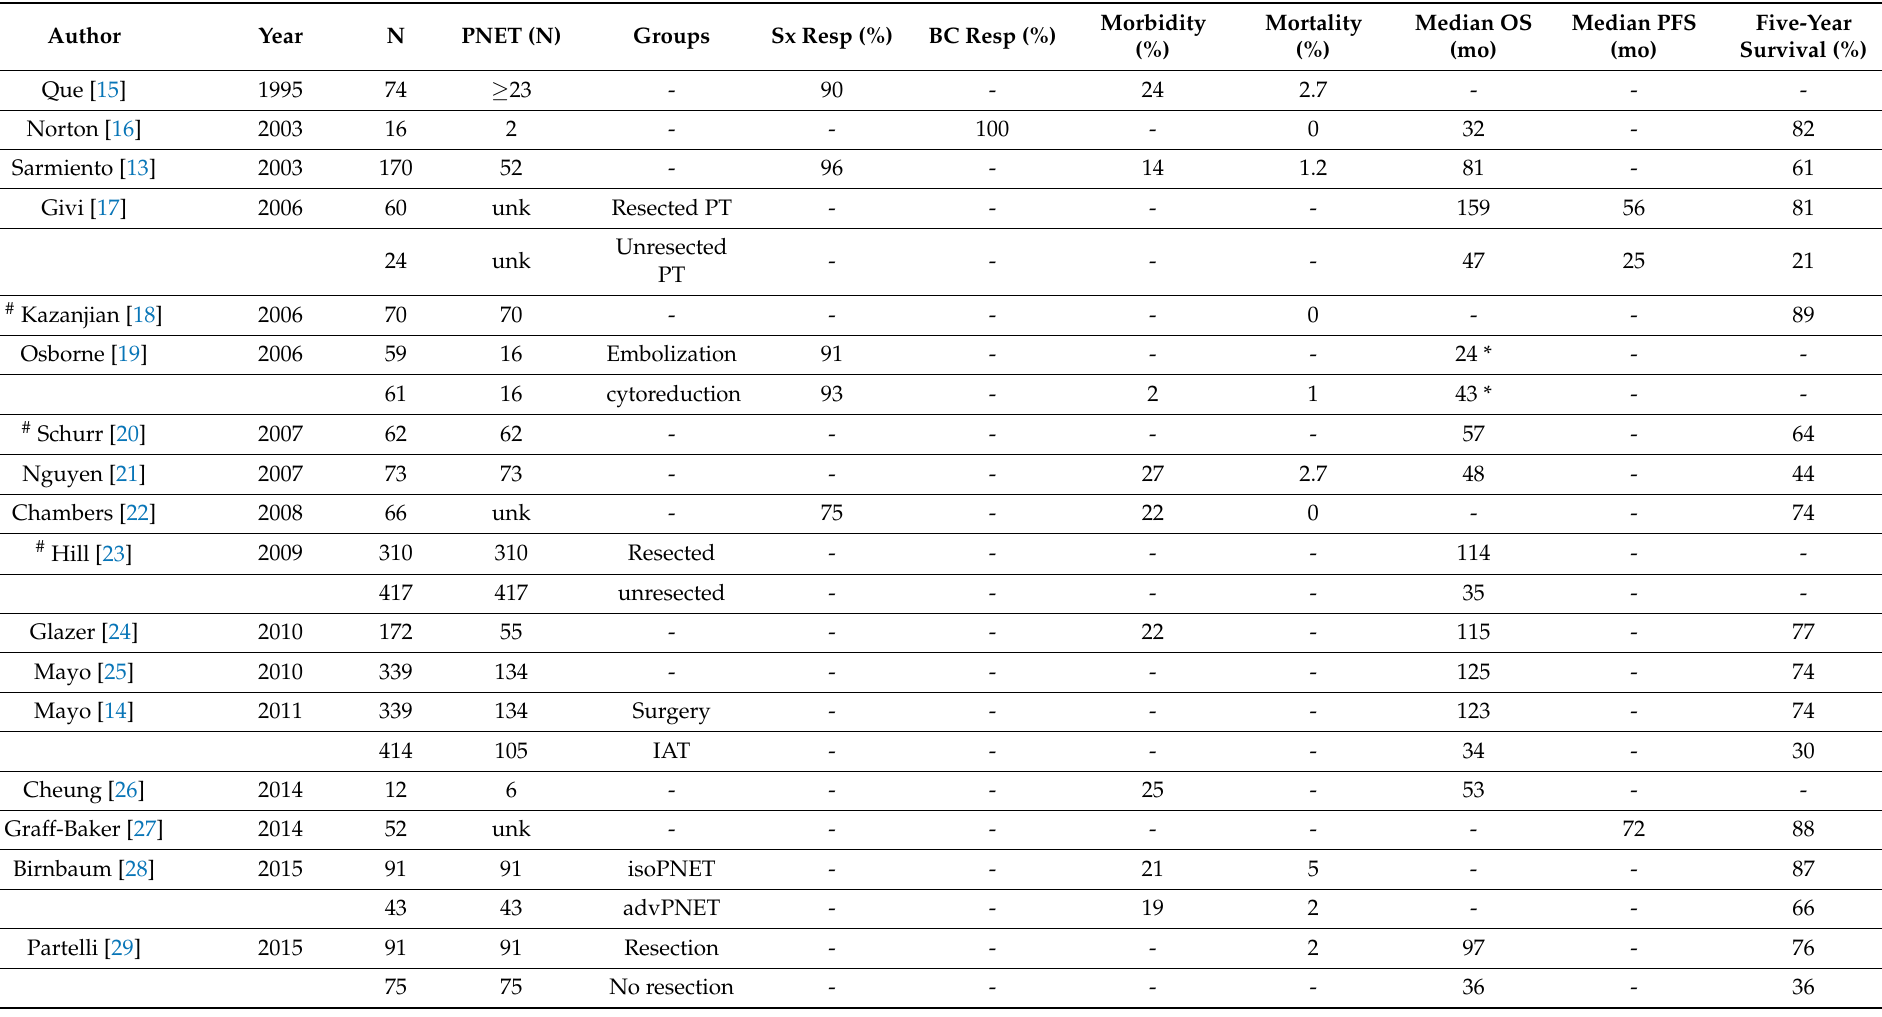
Table 1. Study outcomes of resection of primary tumor with or without hepatic metastasectomy of gastroenteropancreatic neuroendocrine